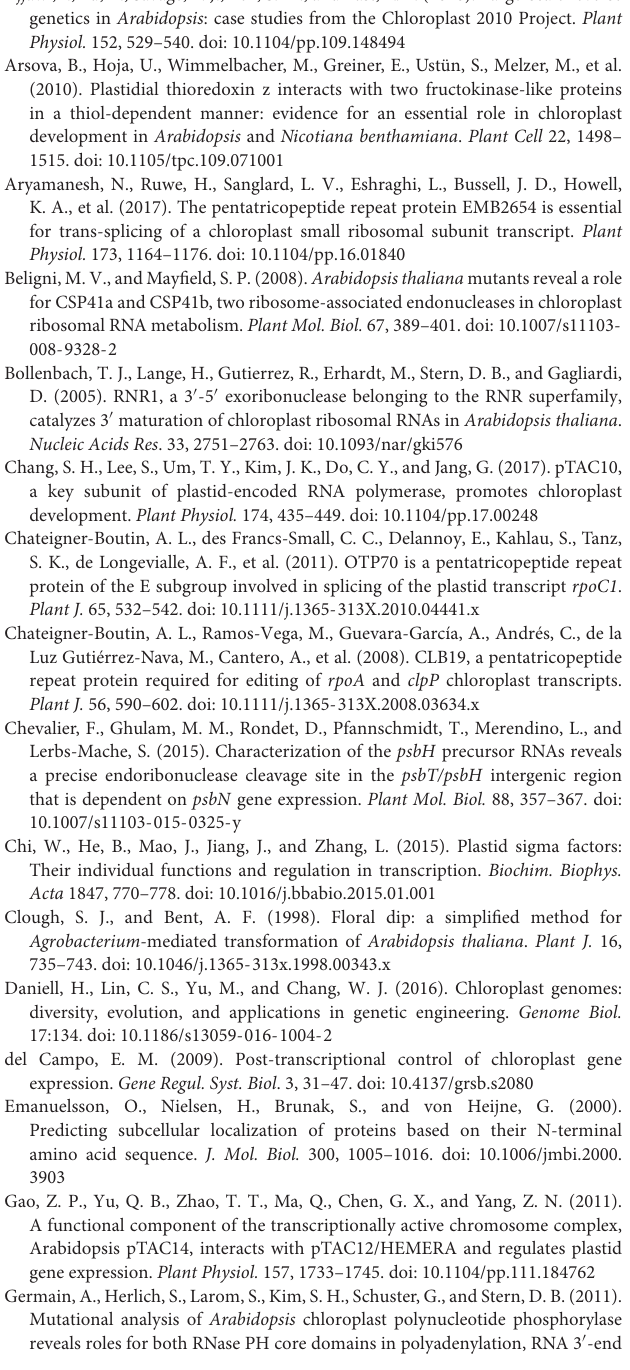
Supplementary Figure 4 | RT-PCR analysis of intron splicing of chloroplast genes in the wild type and the rp8 mutant. Supplementary Figure 5 | Coomassie brilliant blue staining for the wild type and the rp8